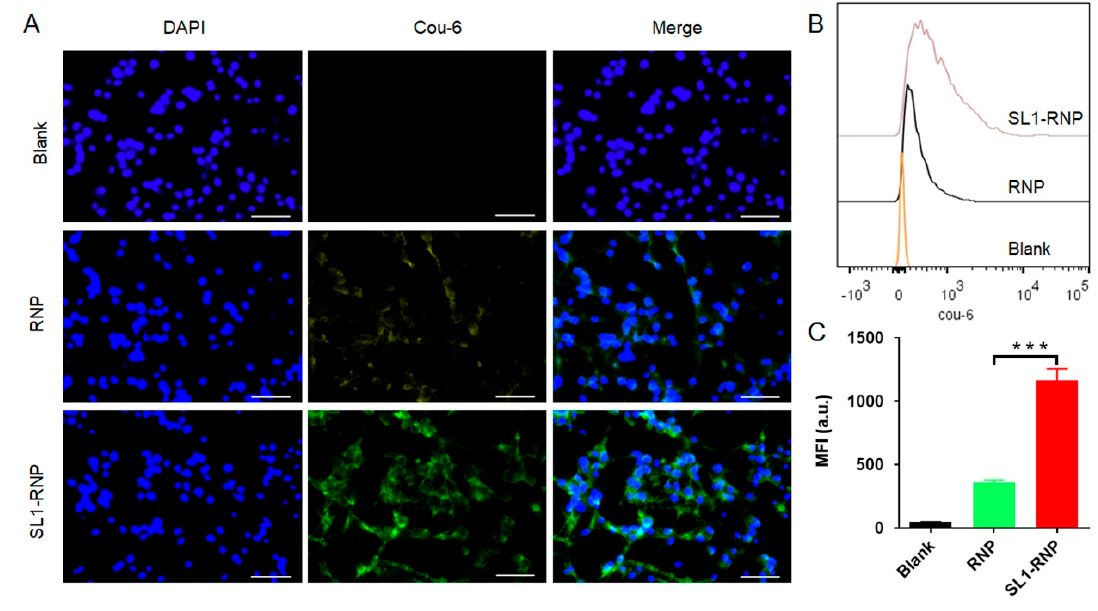
Figure 3. Cellular uptake of Coumarin 6 − labelled SL1 − RNP by U87MG cells. ( A ) Fluorescence images of U87MG cells treated with Coumarin 6 − labelled RNP and SL1 − RNP for 1 h, respectively (scale bar = 100 µ m). ( B ) Representative flow cytometry histograms, and ( C ) the corresponding fluorescence intensity of U87MG cells treated with Coumarin 6 − labelled RNP and SL1 − RNP for 1 h ( n = 3). Cou − 6, Coumarin − 6. MFI, mean fluorescence intensity. *** p < 0.001.